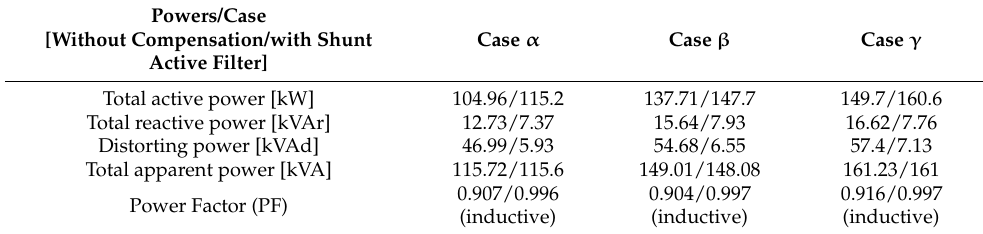
Table 6. Power and power factor quality.